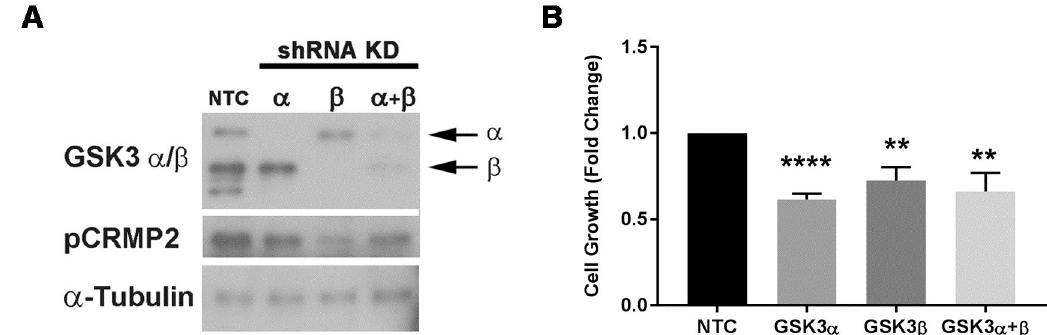
Fig 2. Targeted knockdown of GSK3 by shRNA reduces H1975 cell growth. In Panel A western blot analysis confirms an shRNA-mediated reduction in protein expression of the GSK-3 α and GSK-3 β isoforms in H1975 cells transduced with the GSK3 α +GSK β pooled shRNA, compared to H1975 cells transduced with a non-targeting control (NTC) shRNA (a representative blot from three separate experiments is shown). In Panel B H1975 cells stably transduced with shRNA against GSK3 α , GSK3 β and pooled anti-GSK3 α and -GSK3 β shRNA (GSK3 α +GSK β ) showed significant reduction in cell growth. The data provide the mean ± standard deviation (n = 3) and statistical relevance was determined by standard t -test ( �� p < 0.01 and ���� p < 0.0001 versus the non-transfected control